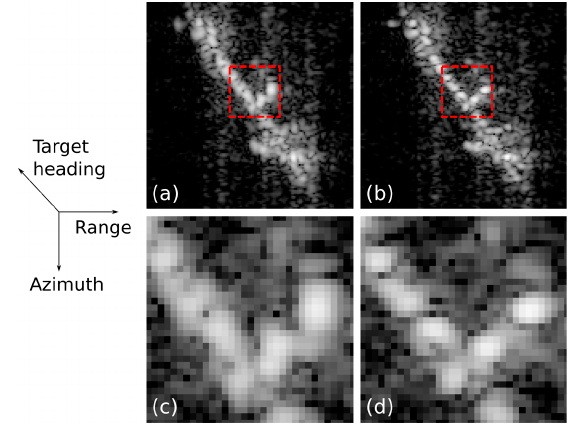
residual phase. The original image size here is 64 by 64 pixels, however, the image was interpolated by analysis [45] was − 5.6 and − 5.1 m/s (or − 20.1 and − 18.4 km/h, respectively) in the azimuth and range